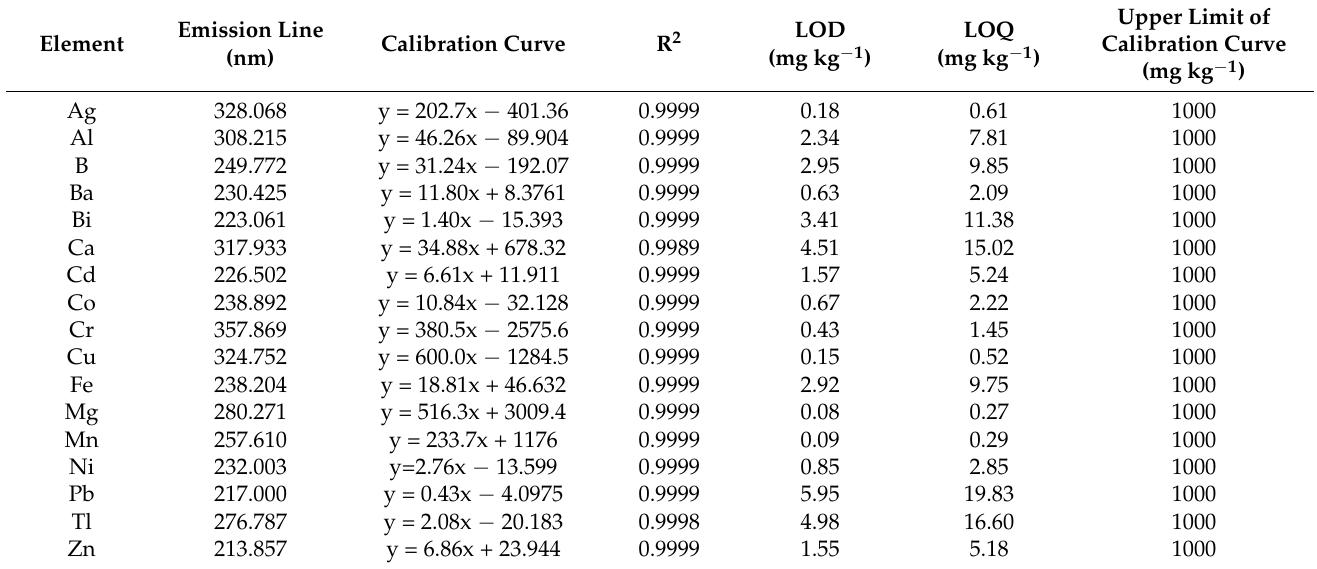
Table 1. Linearity, LODs and LOQs for the examined